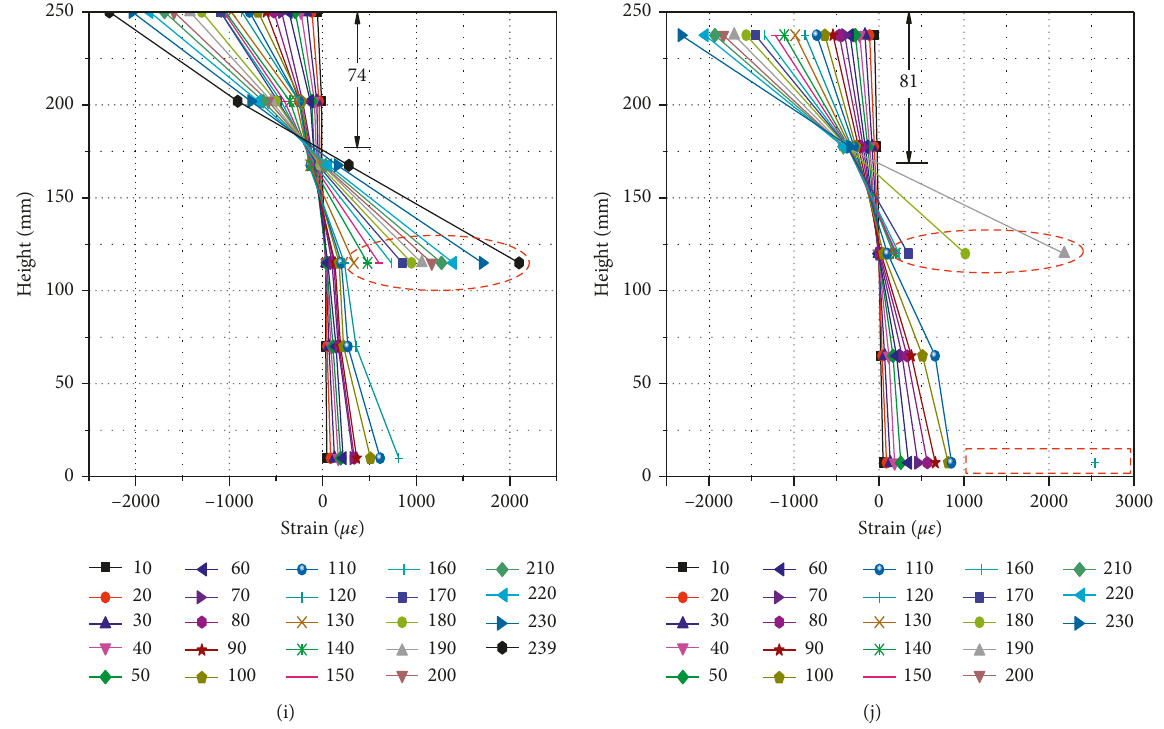
Figure 6: Distribution of strain at the midspan. (a) Beam A1, (b) beam C0-1, (c) beam C40-1, (d) beam C60-1, (e) beam C0-3, (f) beam C40- 3, (g) beam C60-3, (h) beam B2, (i) beam C40-2, and (j) beam C60-2.